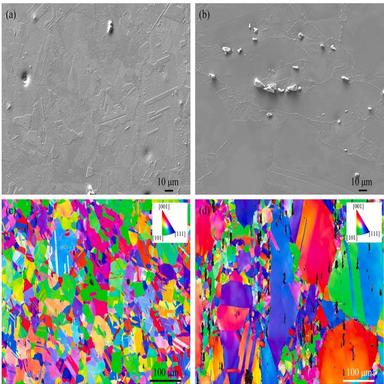
Low magnification images (top) SEM/LEI, and (bottom) orientation maps. (left) IN600 alloy and (right) IN625 alloy.